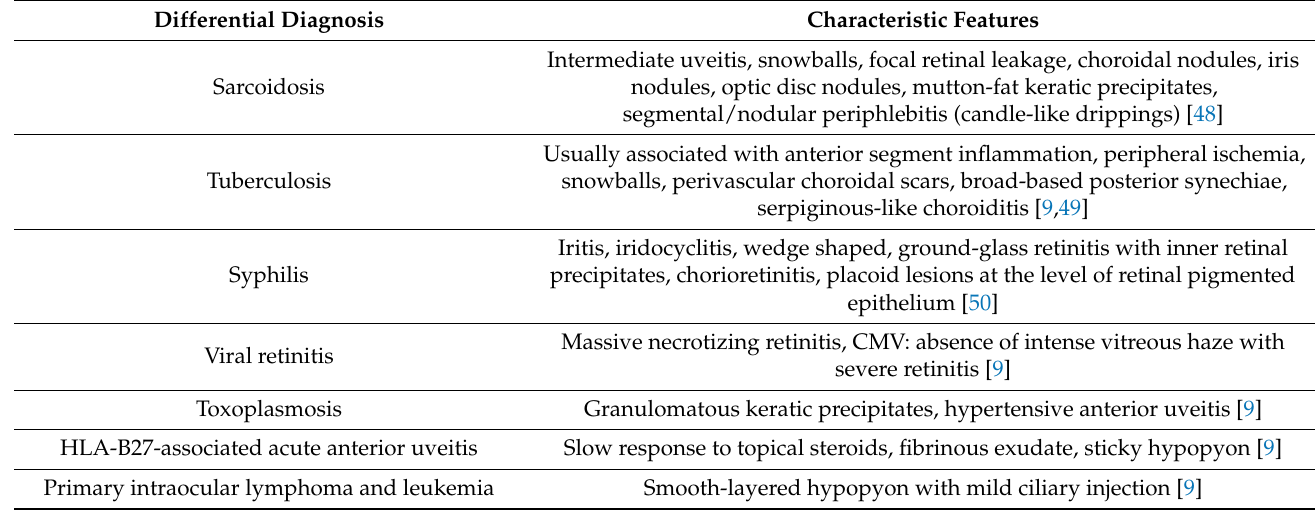
Table 2. Differential diagnosis of Behçet’s disease ocular